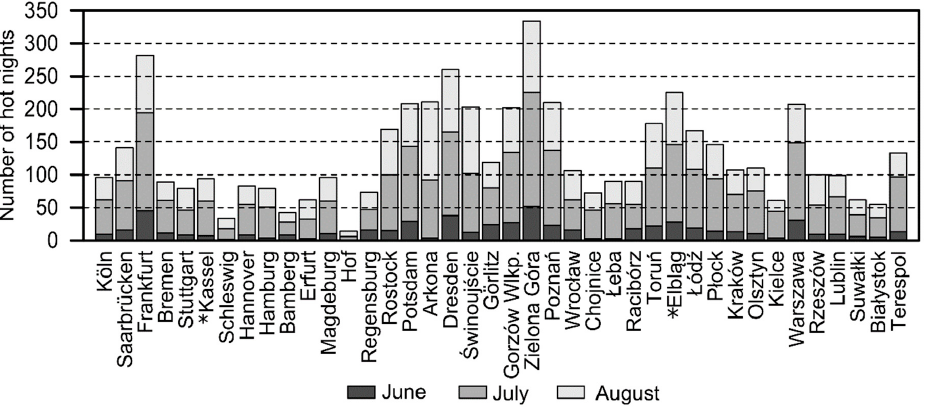
Figure 3. Number of hot nights by month of occurrence in the summers (June–August) 1966–2015 (* stations with a shorter measurement series 1966–2013).